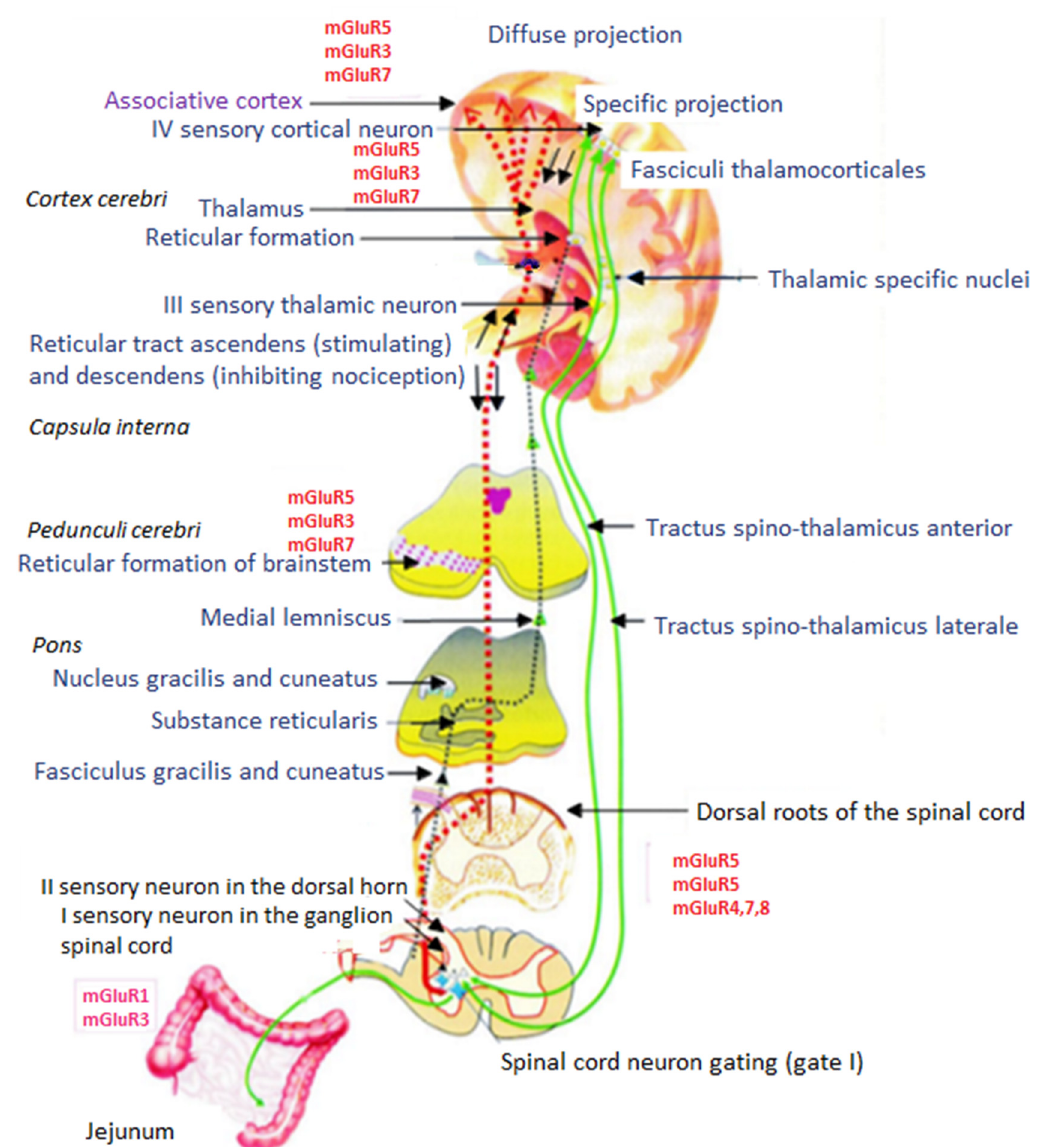
Figure 2. Diagram of specific ascending pathways conducting nociceptive (pain) stimuli and nonspecific ascending (excitatory) and descending (antinociceptive) pathways of the reticular formation. The figure shows pathways of pain conduction from nociceptors located in the intestine, through class IV sensory neurons, to sensory areas of the cerebral cortex and “gating” systems, inhibiting the transmission of nociceptive stimuli in the spinal cord (first gate) and thalamus (second gate). A detailed description of metabotropic glutaminergic receptor (mGluR)-mediated transmission and inhibition of nociception can be found in the text (according to